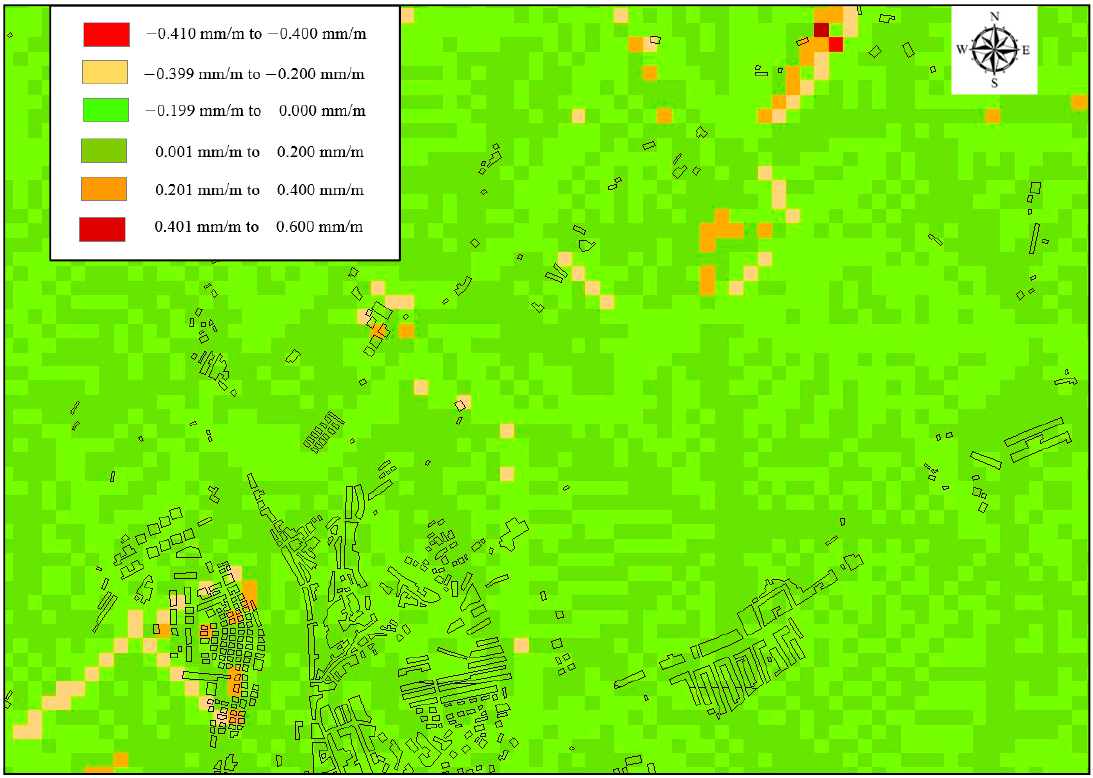
Figure 10. Raster map with the horizontal deformations, in mm/m, using Equation (5). Scale 1:15,000.